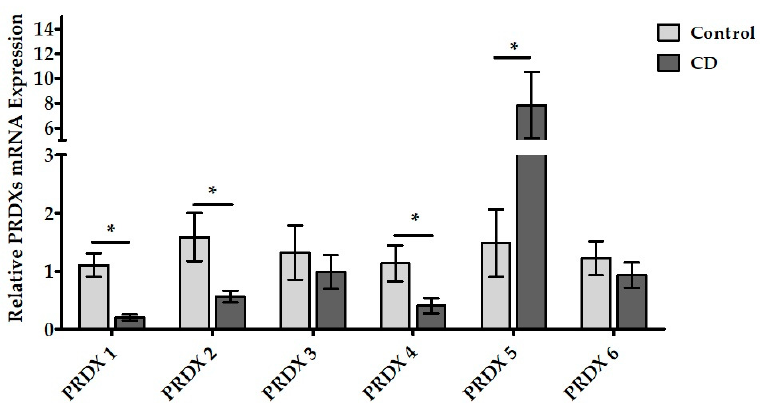
Figure 4. Comparative graph of the relative PRDX (1–6) mRNA expression values. Data were ex- pressed as the mean ± SEM ( n = 7/7). * p < 0.05 versus the control group (CD: celiac disease group).